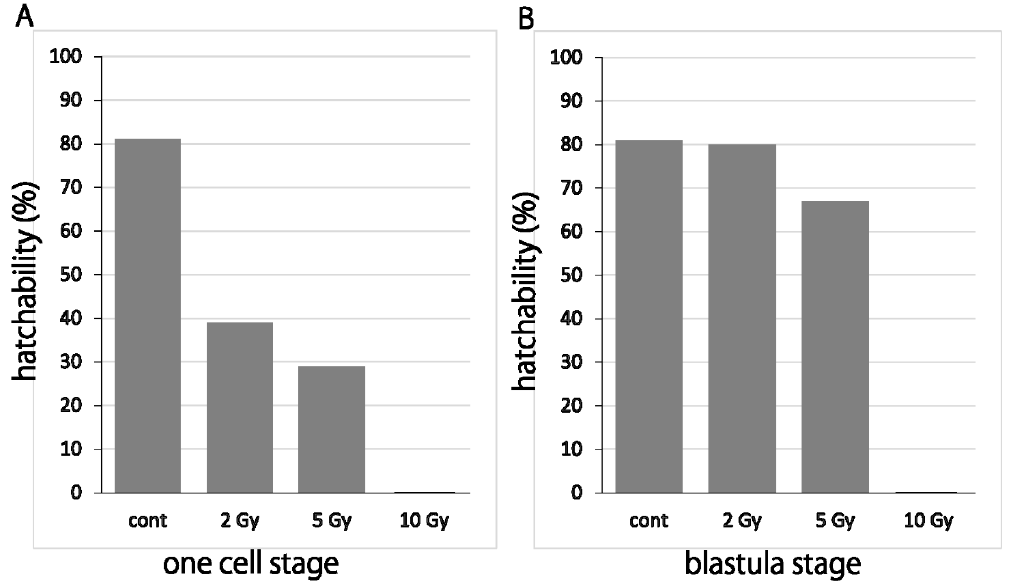
Figure 1. Susceptibility of embryos to irradiation decreased as the development proceeds in extremely early embryogenesis period. One cell stage embryos ( A ) and blastula stage embryos ( B ) were exposed to X-rays (2, 5 and 10 Gy) and gamma-rays (2, 5 and 10 Gy), respectively, and their hatchability were scored.